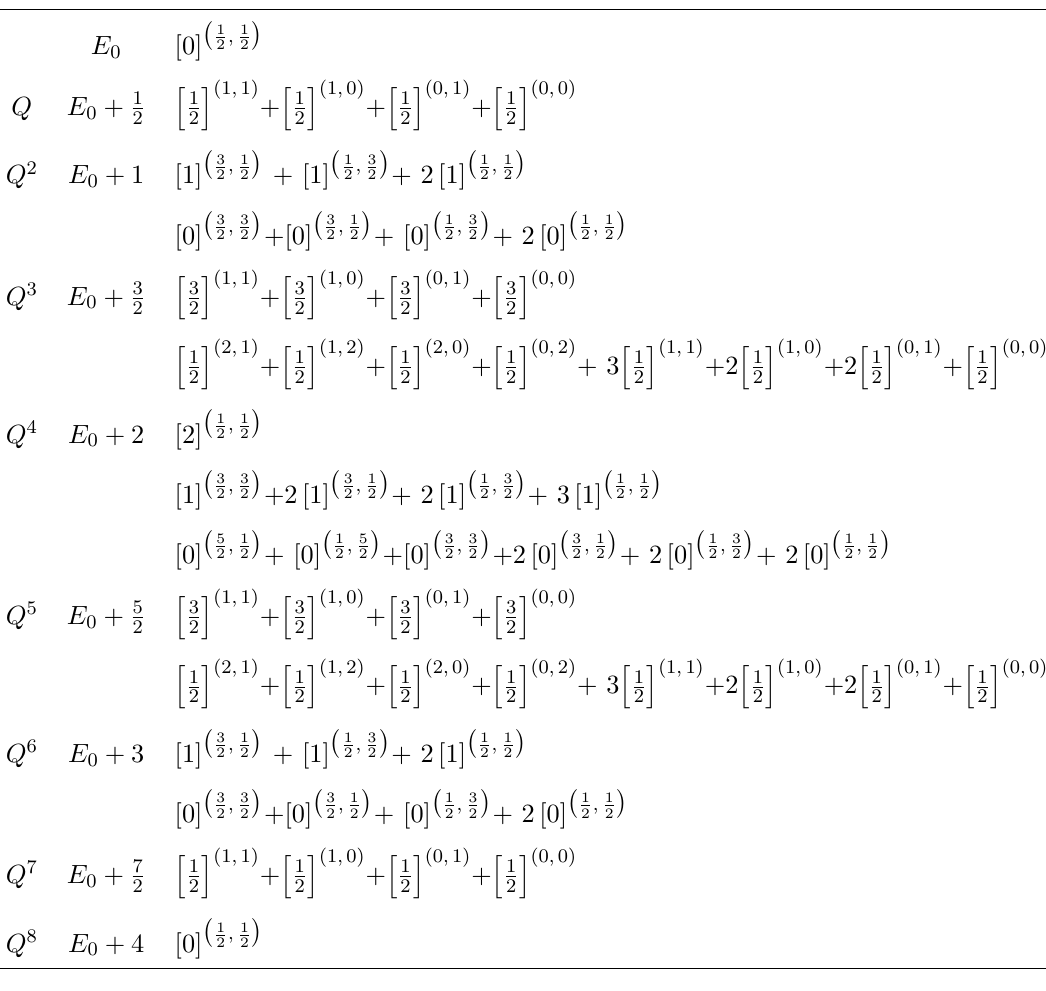
Table 5 . States in the long graviton supermultiplet LGRAV 4